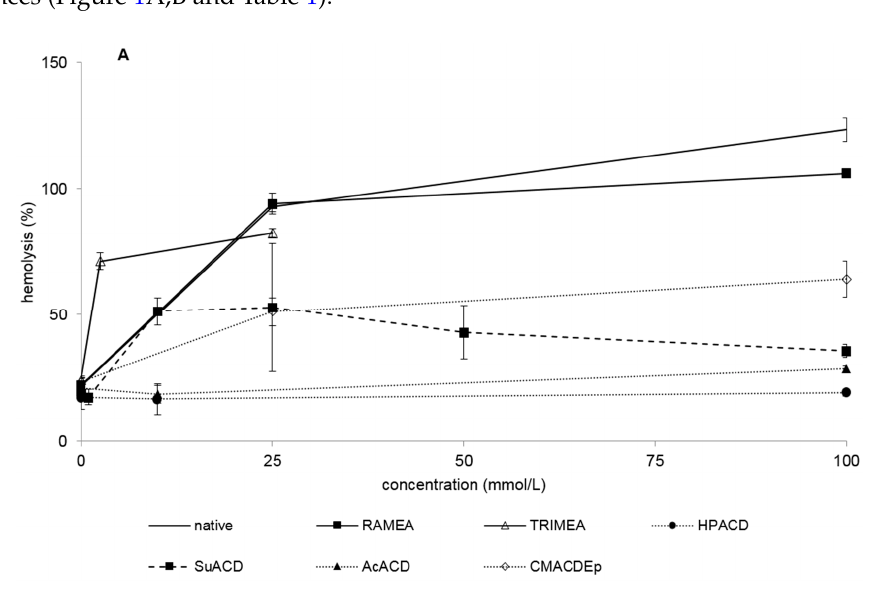
Figure 1. Cont. Figure 1.